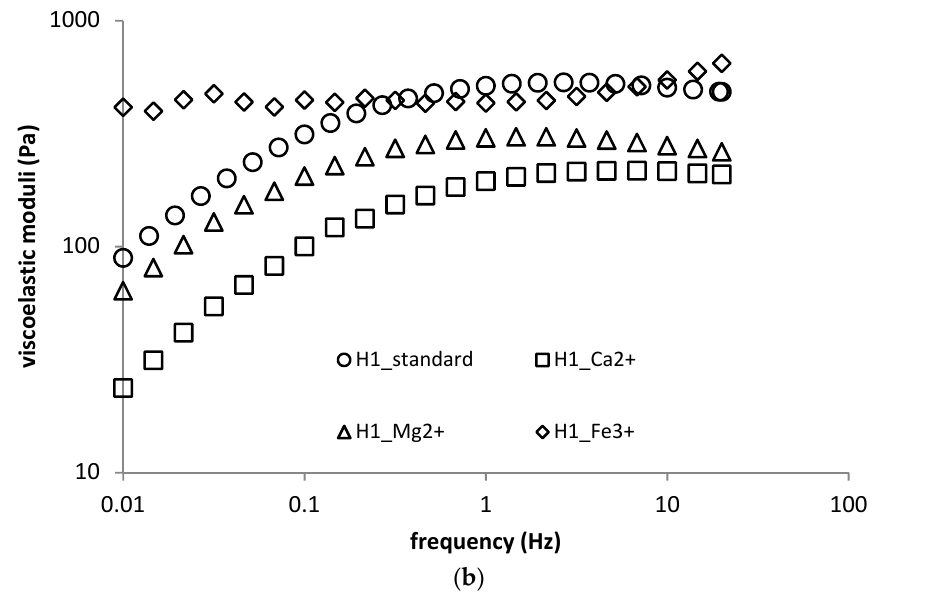
Figure (a) Frequency sweep (storage moduli) for H1 sample—the effect of multivalent ions; (b) Figure 7. ( a ) Frequency sweep (storage moduli) for H1 sample—the e ff ect of multivalent ions; ( b ) frequency sweep (loss moduli) for H1 sample—the e ff ect of multivalent ions Table 5. The e ff ect of multivalent ions to cross-over point in samples, values of frequency and G’ = G".